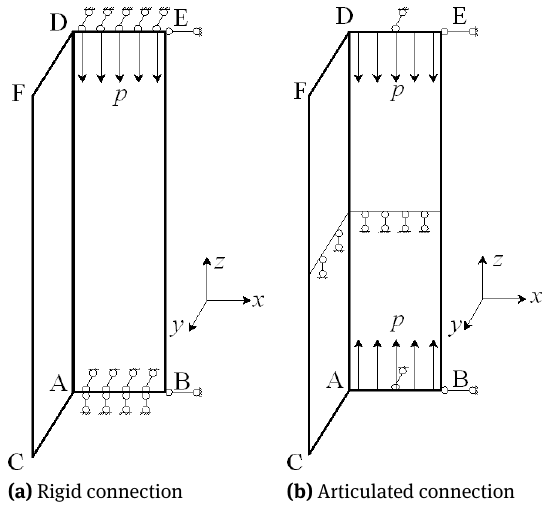
Figure 18: Connection schematic diagrams